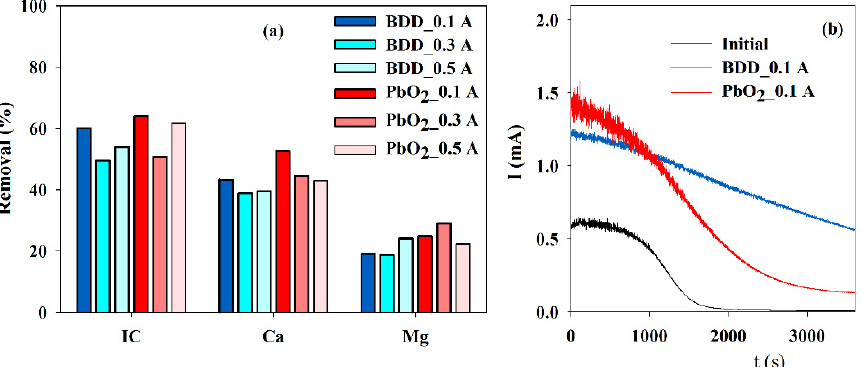
Figure 5. Influence of the anode material and current intensity on the ( a ) IC, Ca 2+ and Mg 2+ removals, during electrolysis (Anode—BDD 20 cm 2 or Ti/Pt/PbO 2 10 cm 2 ; Cathode—SS 10 cm 2 ; Stirring speed—1000 rpm; 4 h) and on ( b ) the chronoamperometric tests (E = − 0.96 V vs. Ag/AgCl) run with S solution before and after the electrolytic assays run at 0.1 A, with different anode material.